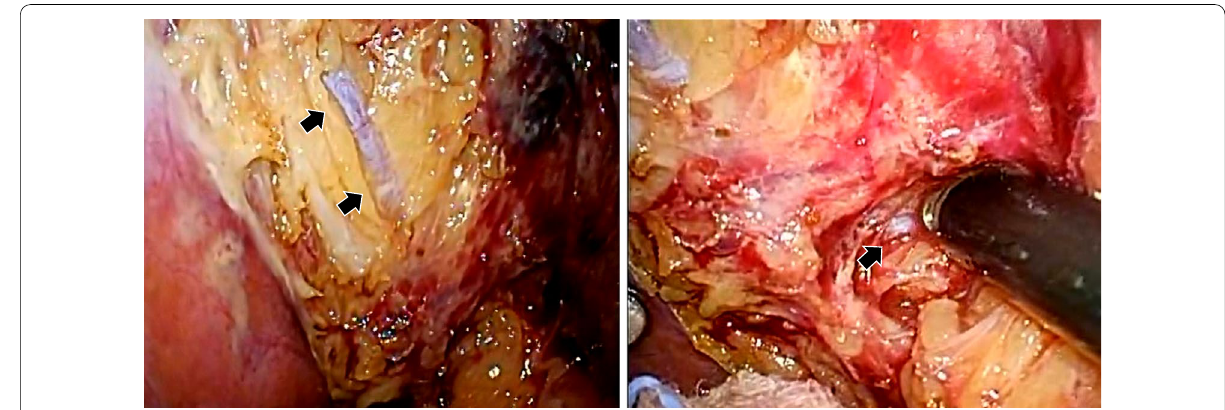
Fig. 3 Intraoperative findings in a 69-year-old woman with cholelithiasis and aberrant biliary duct. Static image extracted from the intraoperative video showing the aberrant biliary duct of segment 5 (black arrow) after separation from the